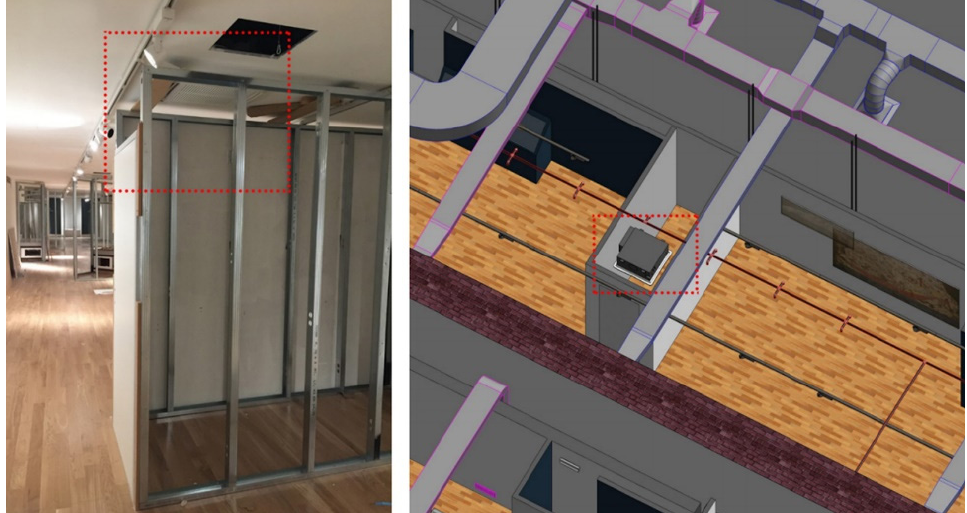
Figure 9. Clearance clash of the fan coil detected during the construction site phase of the “Invisible Archaeology” exhibition. Comparison between construction site and the BIM environment. Image by Arch. M. Cammarano.